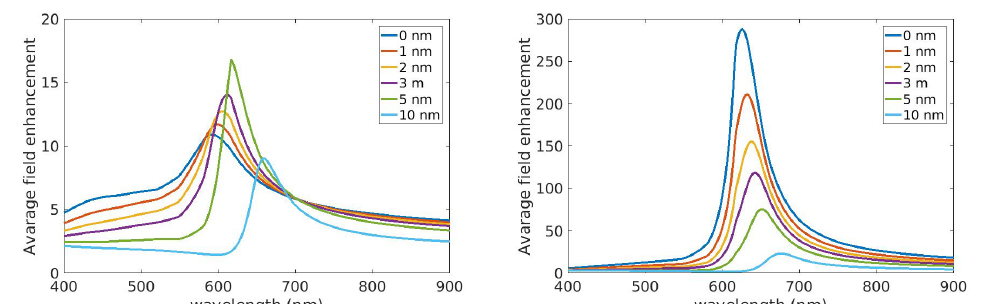
Figure 9. Average field enhancement over Cu particle surface with radius a = 25 nm in water assuming different Cu 2 O shell thickness. Left: single particle. Right: particle dimer separated by 2 nm and excited by a plane wave polarized in the dimer axis direction. Note the different ranges for the average field enhancement